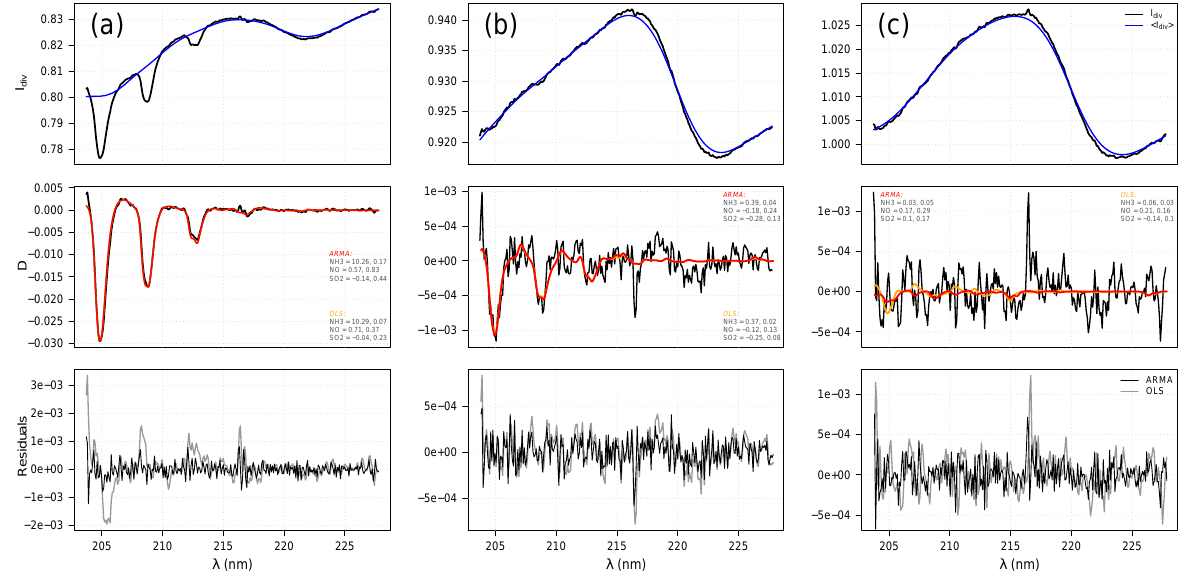
= 10.26µgm − 3 ) , (b) a small 3